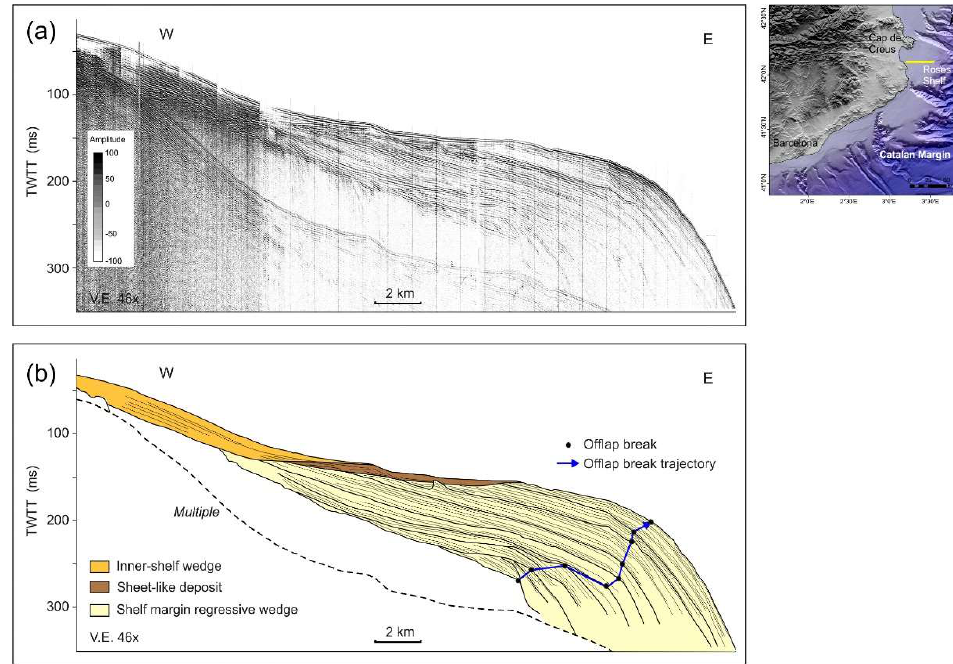
Figure 5. ( a ) Uninterpreted and ( b ) interpreted high-resolution Uniboom seismic reflection profile of the Roses Shelf. Most of the shelf stratigraphic record is composed by shelf-margin regressive wedges, except the postglacial record, with identification of transgressive (sheet-like deposit) and highstand (inner-shelf wedge) features. The shelf-edge trajectory evolved from flat to ascending, suggesting a change of the tectonic regime. Modified from [6].